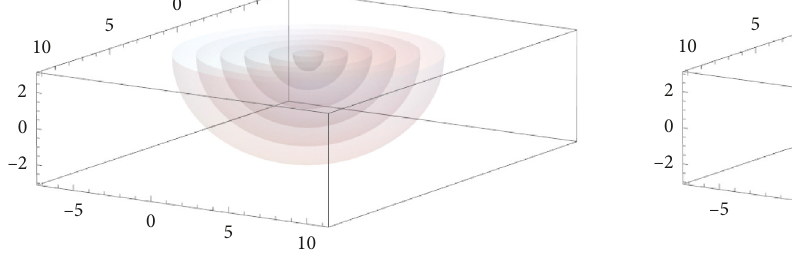
Figure 16: A − B 2 D � 3 D .